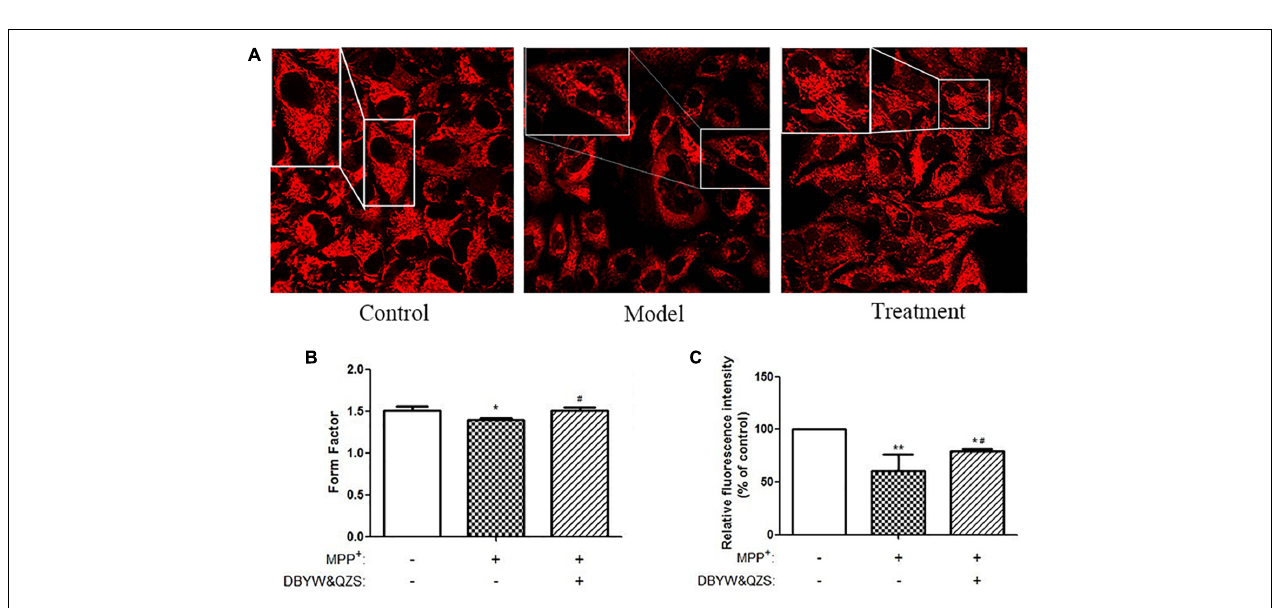
FIGURE 2 | Analysis of mitochondrial morphology and activity. (A) Changes in mitochondrial morphology were observed in cells. Mitochondria were labeled by pulsing with MitoTracker Red and assessed by confocal fluorescence microscopy (100). (B) FF of mitochondria in each group. (C) Analysis of mitochondrial activity. Data were expressed as mean ± standard deviation ( n = 3). Compared with the control group, ∗ P < 0.05; ∗∗ P < 0.01; Compared with the model group, # P <